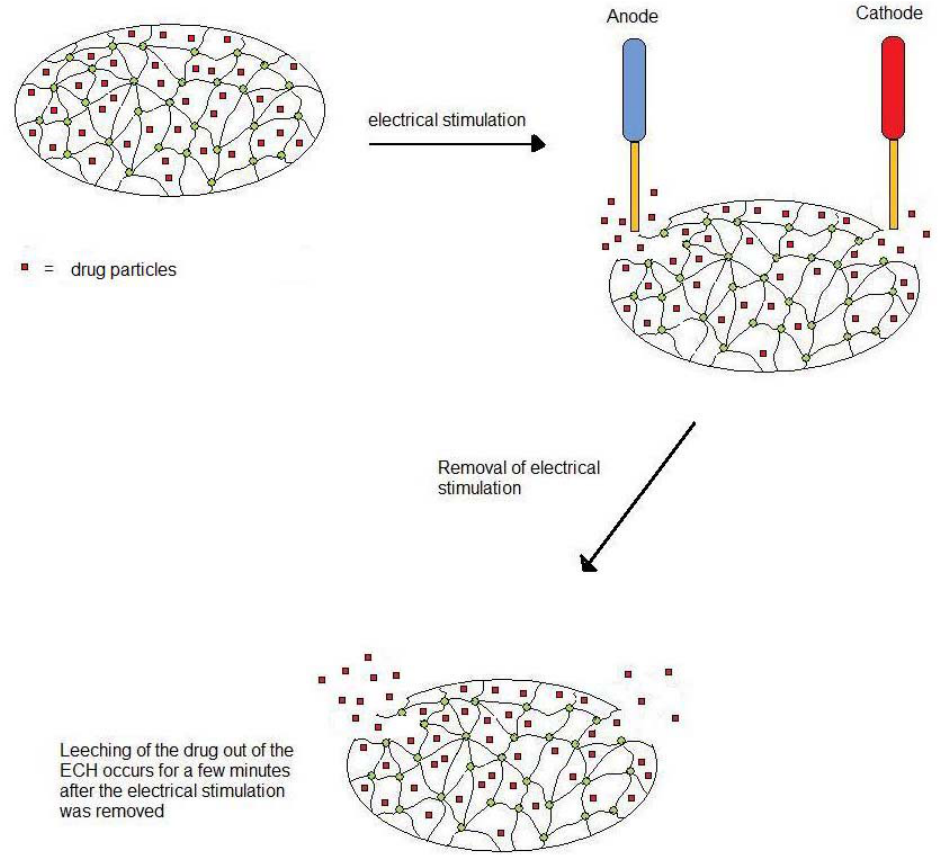
Figure 6. Schematic depicting the potential mechanism of drug release from the